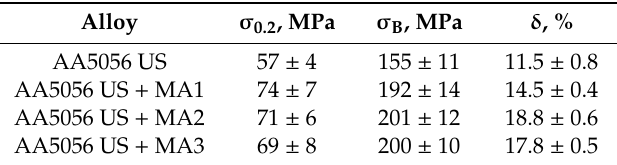
Table 3. Mechanical properties of as-cast AA5056-based alloys.